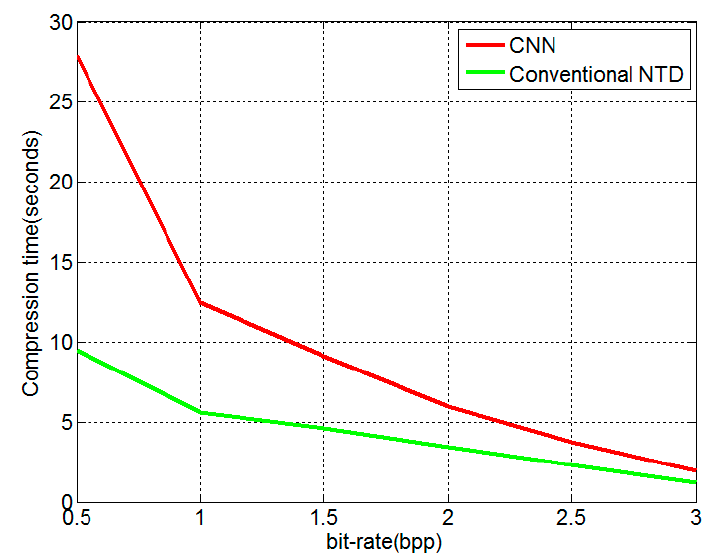
Figure 9. Compress time occupied by two methods. Remote Sens. 2019 , 11 , x FOR PEER REVIEW